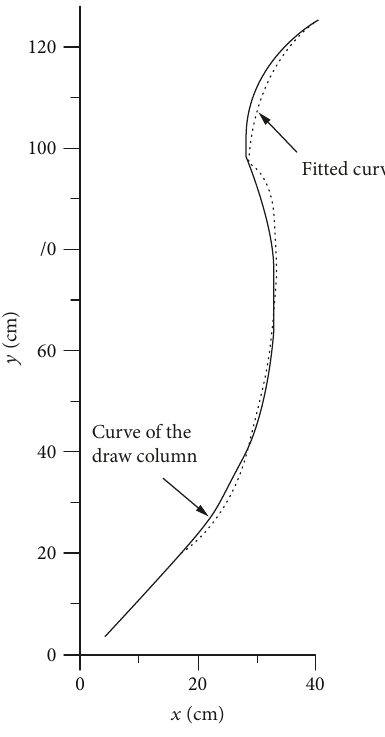
Figure 7: Comparison graph of the curve of the draw column on the right side and fi tting curve at the end of draw.